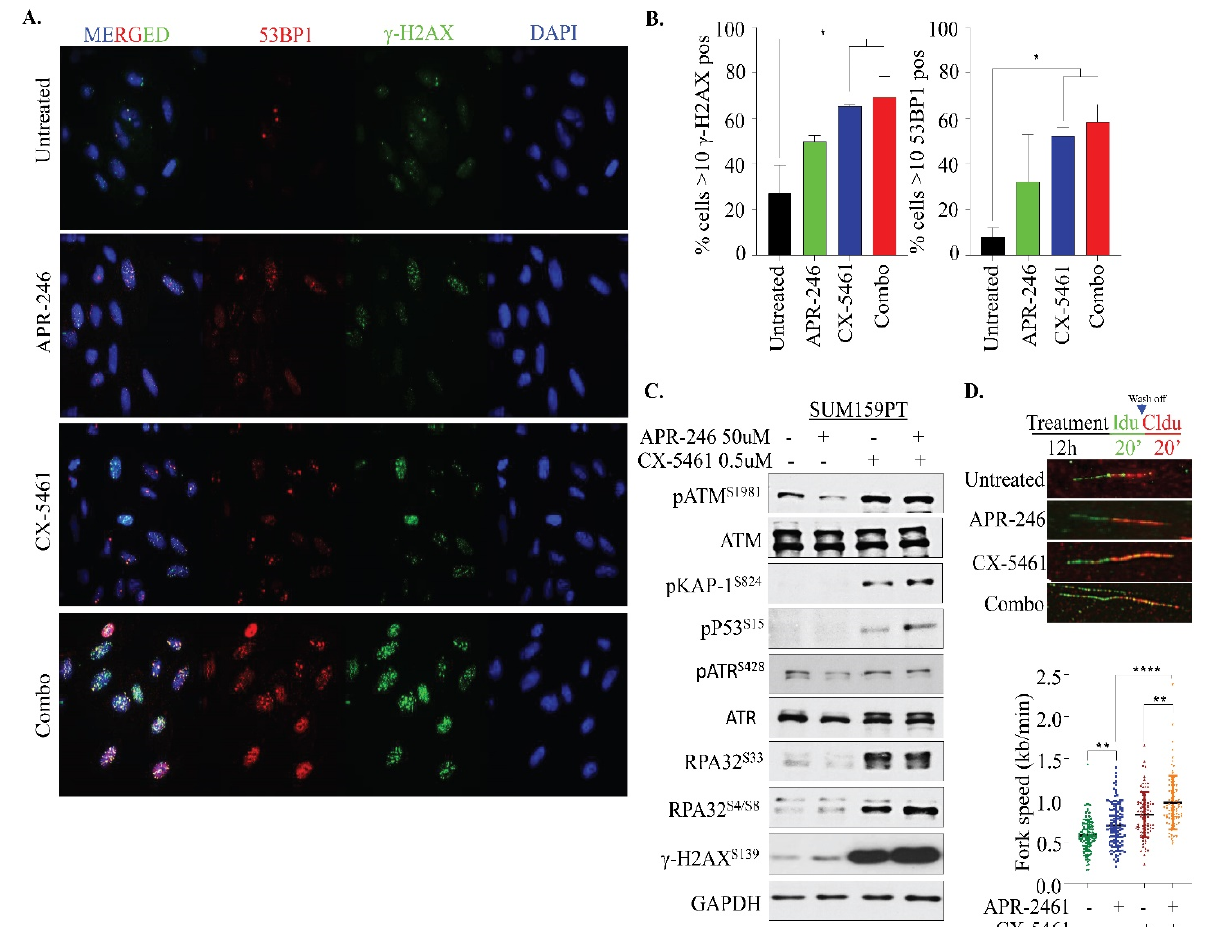
Figure 5. Impact of CX-5461 and APR-246 treatment on DNA damage and replication stress. ( A ) Immunofluorescence analysis of SUM159PT cells treated with APR-246 (25 µM) and CX-5461 (0.5 µM) as single agents and in combination for 12 h. The number of γ -H2AX (green) and 53BP1 (red) foci positive cells were determined. The augmented staining intensity can be correlated to the enhanced DNA damage response induced by the combination therapy. Fluorescence images are from representative fields for independent experiments ( n = 2) carried out in duplicate. ( B ) Graph shows quantification of the percentage of cells with > 10 γ H2AX and 53BP1 foci. Statistical analysis was performed using one-way ANOVA and Dunnett’s multiple comparisons test. * p ≤ 0.05 ( C ) Western blot analysis of expression of DNA damage response signaling proteins. The SUM159PT cells treated with APR-246 (50 µM), CX-5461 (0.5 µM) alone and in combination for 24 h were analyzed for indicated protein expression. GAPDH was used as a loading control. ( D ) Schematic and representative images of DNA fiber, and quantification of the fork seeds (kb/min) in SUM159PT cells treated APR-246 (50 µM), CX-5461 (0.5 µM) alone and in combination for 12 h. ** p ≤ 0.01; **** p ≤ 0.0001.